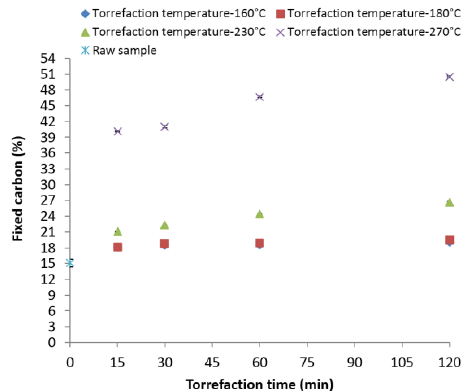
Figure 7. Fixed carbon content in the lodgepole pine grind with respect to the torrefaction temperature and time.